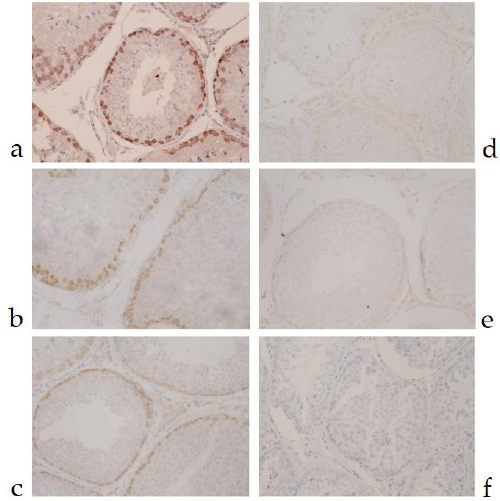
Figure 1. Positive cross-reactivity of MAb 6C1, testis and canines. The detection of MAGE antigen Figure 1 . Positive cross - reactivity of MAb 6C1, testis and canines . The detection of MAGE antigen in in canine testicular tissue sections at di ff erent dilutions using IHC method (40 × ). ( a – e ) MAb 6C1 canine testicular tissue sections at different dilutions using IHC method ( 40× ). ( a – e ) MAb 6C1 in in phosphate bu ff er solution (PBS) in dilutions of 1:100, 1:200, 1:400, 1:800 and 1:1000, respectively; phosphate buffer solution ( PBS ) in dilutions of 1 : 100, 1 : 200, 1 : 400, 1 : 800 and 1 : 1000, respectively; ( f ) Vet . Sci . 2020 , 7 , x FOR PEER REVIEW ( f ) negative control (normal mouse serum in PBS in a dilution of 1:200). negative control ( normal mouse serum in PBS in a dilution of 1 : 200 ) .